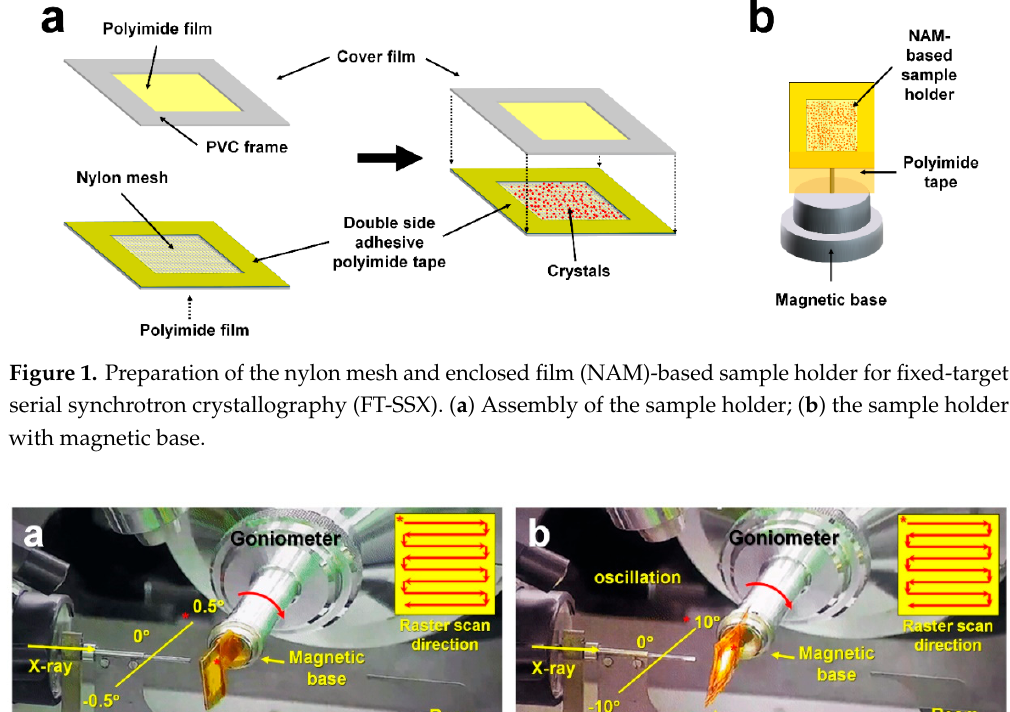
Figure 1. Preparation of the nylon mesh and enclosed film (NAM)-based sample holder for fixed- target serial synchrotron crystallography (FT-SSX). ( a ) Assembly of the sample holder; ( b ) the sample holder with magnetic base.